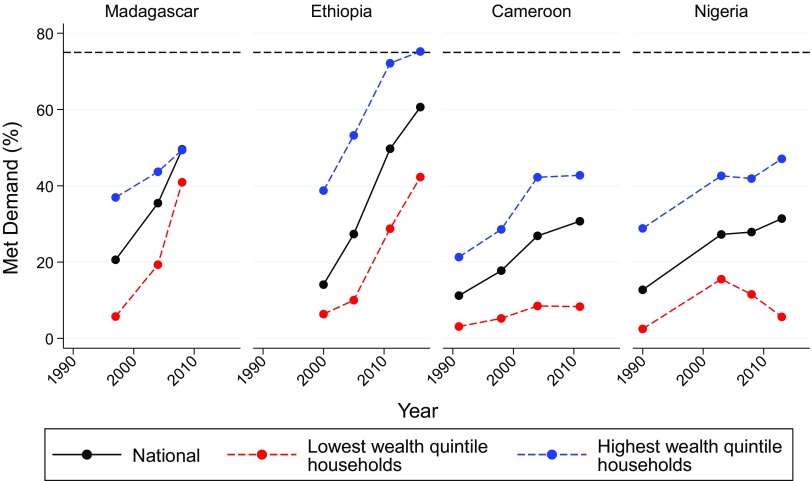
Illustrative Examples of Varying Trends of Family Planning Demand Met With Modern Methods (%), Nationally and by Household Wealth Quintile